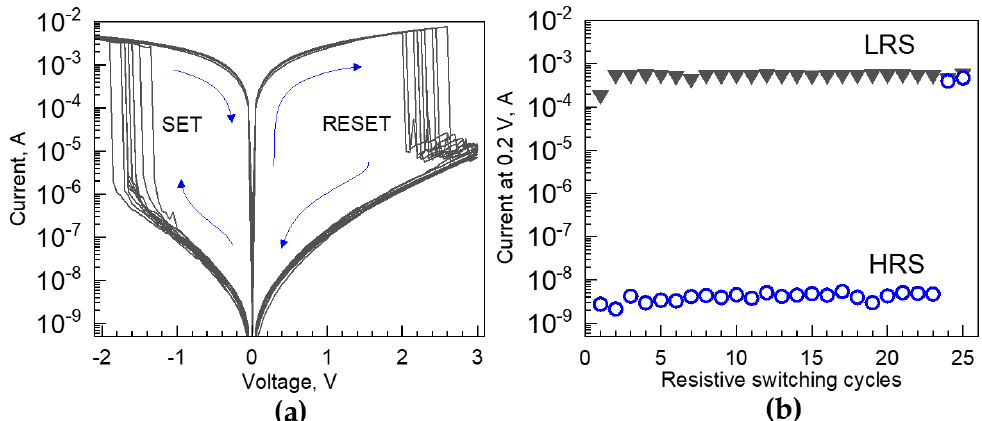
Figure 9. ( a ) Current–voltage and ( b ) endurance characteristics measured in resistive switching regime on an Au/Ti/ZrO 2 :Al 2 O 3 /TiN structure containing ZrO 2 :Al 2 O 3 films grown to a thickness of 14.3 nm using the deposition cycle sequence of 6 × (1 × Al 2 O 3 + 24 × ZrO 2 ).